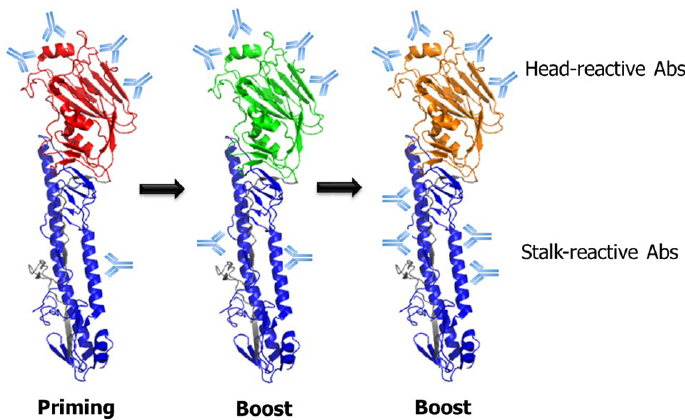
Figure 3. Schematic illustration of prime/boost vaccination strategy based on chimeric HA (cHA) for the boosting of HA stalk-reactive antibodies. With each priming or boost immunization, with the cHA comprising divergent globular head domains and the same stalk domains, the antibody responses are likely to be redirected toward the conserved stalk domain. This strategy has been applied to various vaccine formats, such as recombinant protein vaccines, DNA vaccines and virus-vectored vaccines. In addition, a similar approach could be potentially extended to live attenuated influenza vaccines based on the reverse genetic platform for engineered influenza viruses